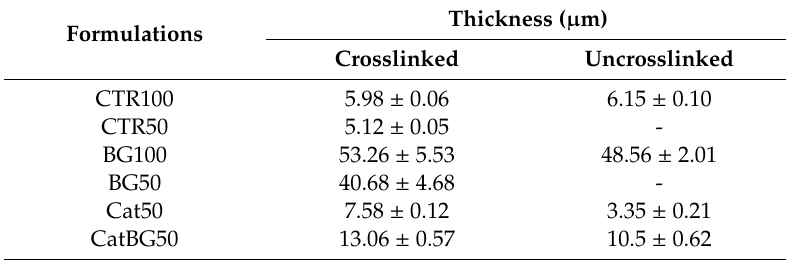
Table 3. Dry thickness of the LbL films before and after crosslinking with genipin estimated through the SEM images using the ImageJ software (National Institutes of Health, Bethesda, MD,